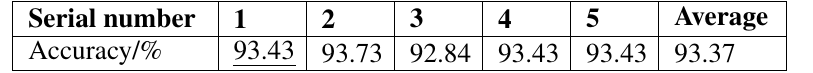
Table 4 Diagnosis results based on the colour matrix of the centreline of the insulator